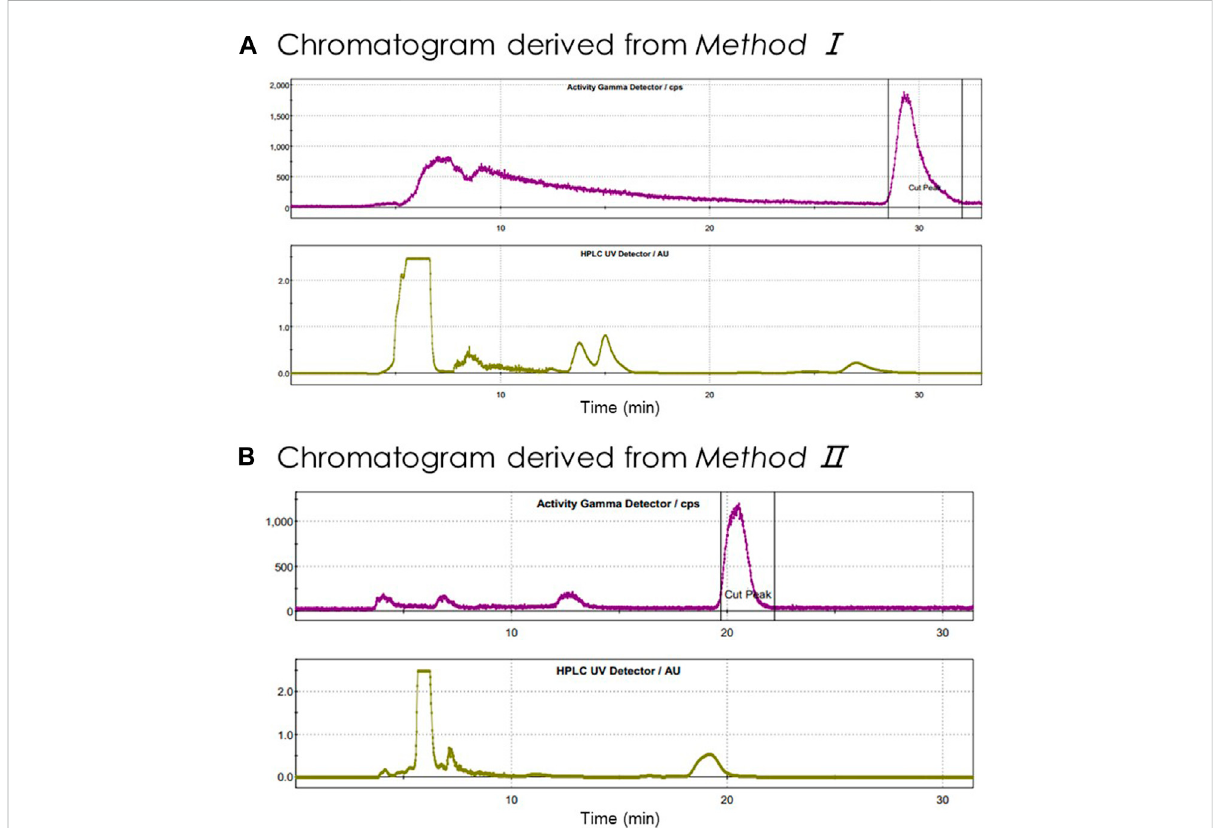
FIGURE 3 Semipreparative HPLC chromatography of crude radioligand [ 18 F] 3 . Units on y -axis are arbitrary. Column: OS Ʌ K Ʌ SOD Ʌ , CAPCELL PAK C18, UG80 5 μ m, 250 × 10 mm; (A) mobile phase: CH 3 CN/H 2 O = 55/45 (v/v); fl ow rate: 5 ml/min; Gamma (t R = 29 min; purple) and UV ( λ = 254 nm; yellow); (B) mobile phase: CH 3 CN/H 2 O = 60/40 (v/v); fl ow rate: 3.5 ml/min; Gamma (t R = 21.8 min; purple) and UV ( λ = 254 nm;